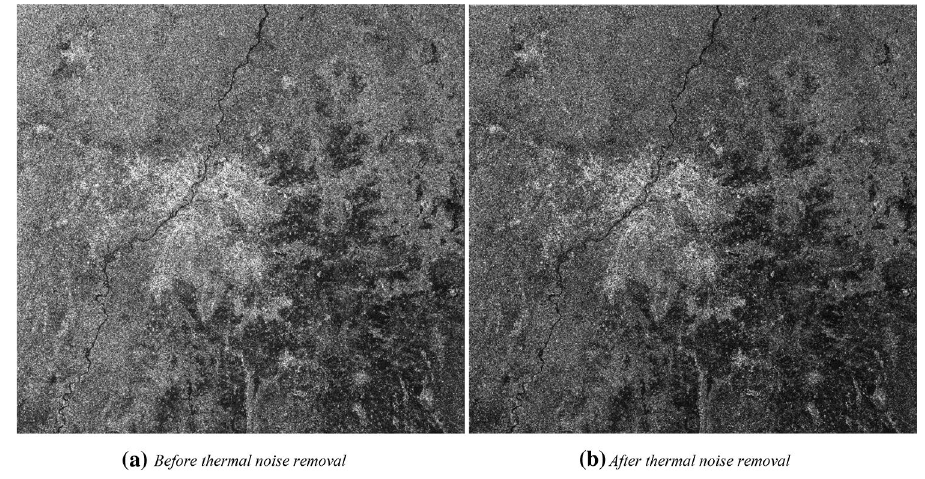
Figure 5. Effect of thermal noise removal in VH polarisation.